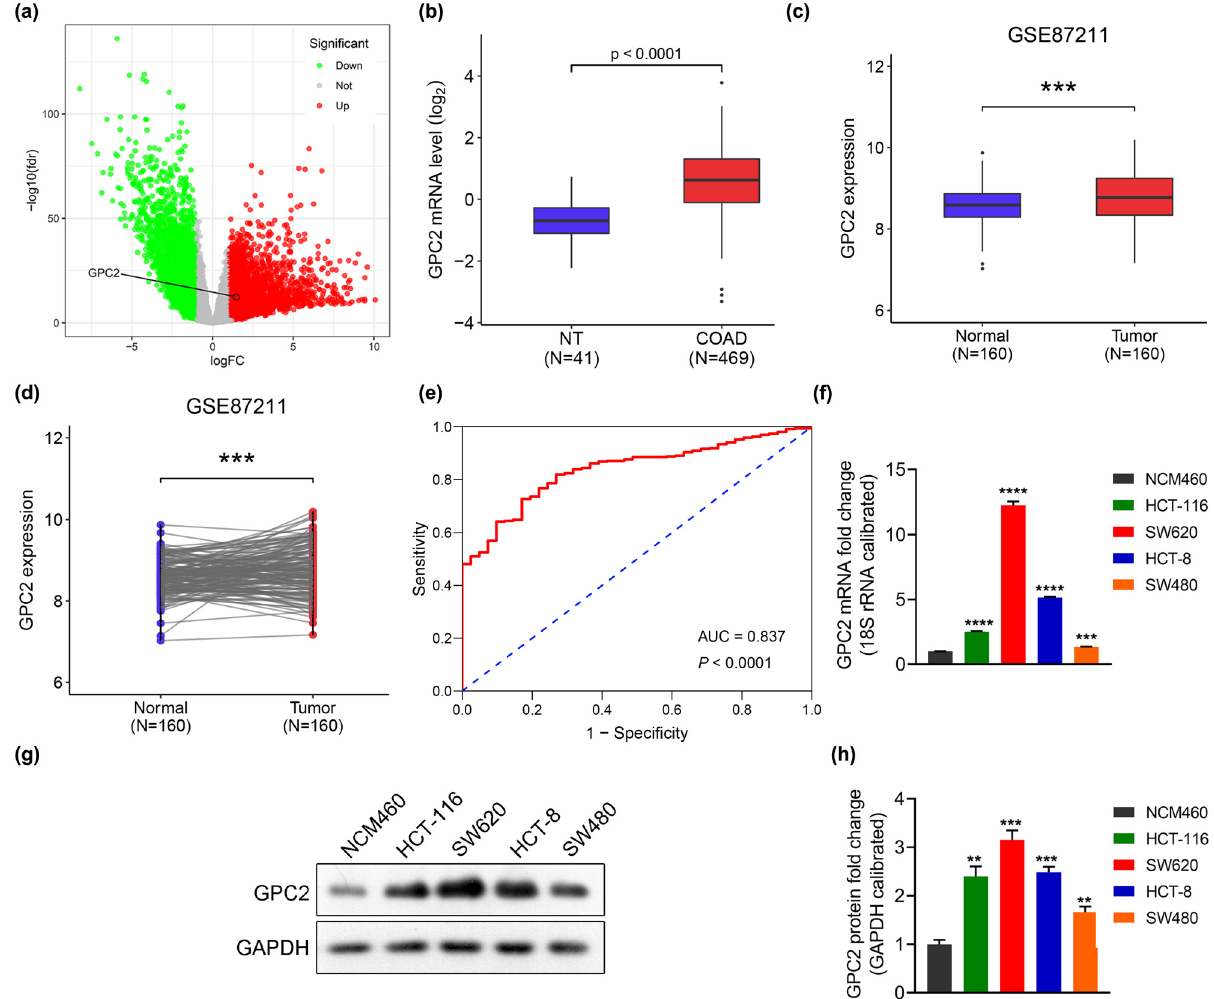
Figure 1: The mRNA level of GPC2 is signi fi cantly upregulated in COAD tissues: ( a ) volcano plot of gene expression in patients with COAD, ( b ) the di ff erence in GPC2 expression in nontumor tissues ( n = 41 ) and COAD tissues ( n = 469 ) was analyzed, ( c ) the di ff erence in GPC2 expression in nontumor tissues ( n = 160 ) and COAD tissues ( n = 160 ) from GEO was analyzed, ( d ) di ff erential expression of GPC2 in adjacent normal tissues ( n = 160 ) and tumor tissues ( n = 160 ) from GEO, ( e ) validation of the diagnostic value of GPC2 upregulation in COAD using an ROC curve, ( f ) the mRNA level of GPC2 in COAD cell lines was detected using RT - PCR ( n = 3 ) , and ( g and h ) Western blotting was used to detect the protein level of GPC2 in COAD cell lines ( n = 3 ) . logFC: log2 fold change, NT: not tumor, COAD: colon adenocarcinoma, *** P < 0.001, **** P <